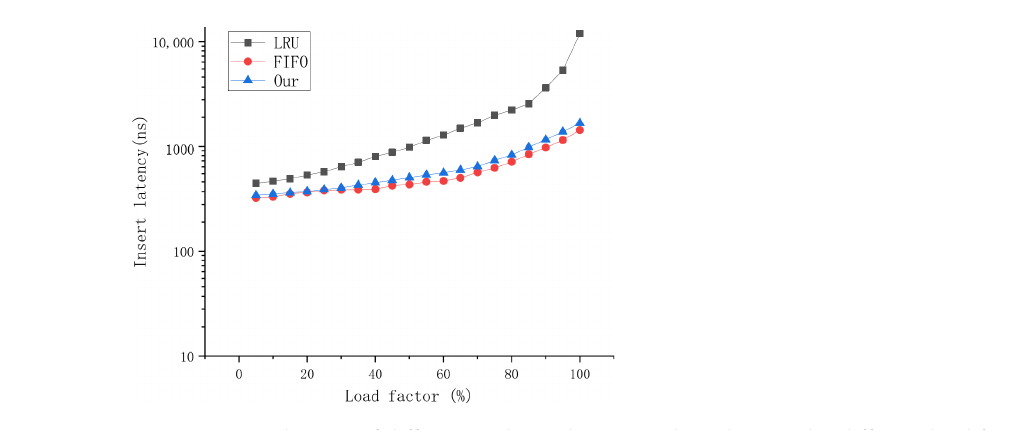
Figure 7. Insert latency of different cache replacement algorithms under different load factors in the single-core.